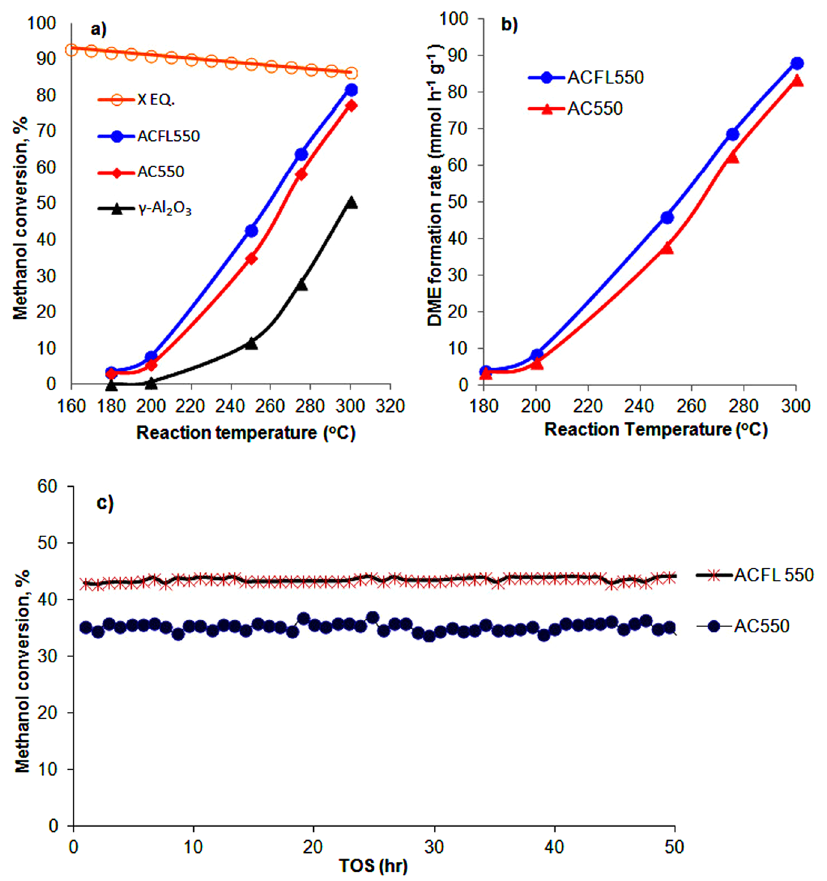
Figure 5. The catalytic conversion profiles of methanol dehydration of ACFL550, AC550 and the commercial γ -Al 2 O 3 catalysts, ( a ) the % methanol conversion and ( b ) the DME formation rate (mmol h reaction conditions of 180–300 °C with a WHSV of 12.1 h − 1 and ( c ) the time on stream test at 250